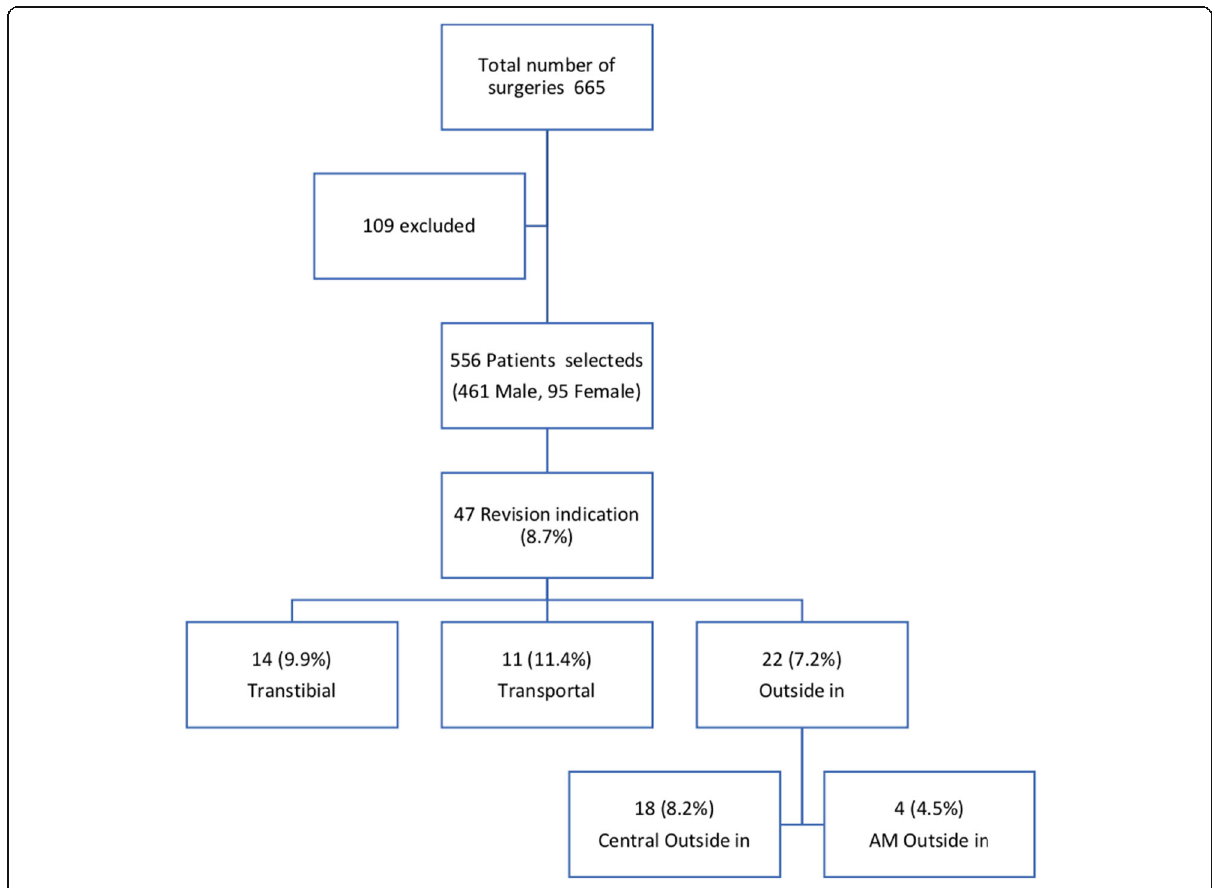
Table 2 Relationship between performance of the review and surgical technique employed and placement of the femoral tunnel using the chi-square test